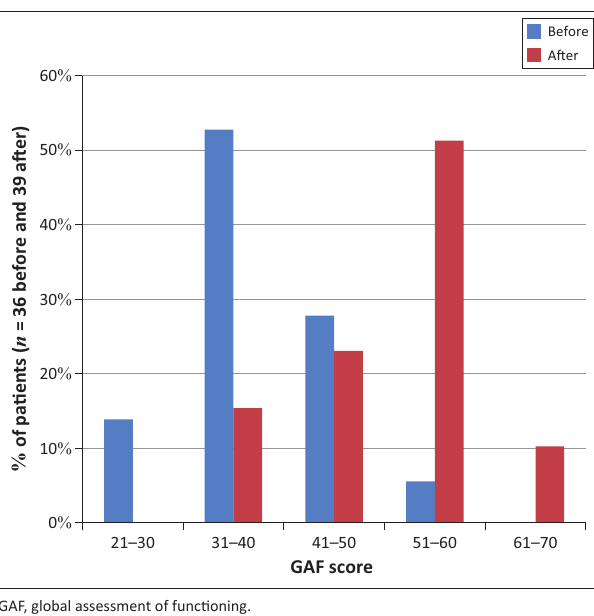
FIGURE 1: Global assessment of functioning score before ( n = 36) and after ( n = 39) initiation of